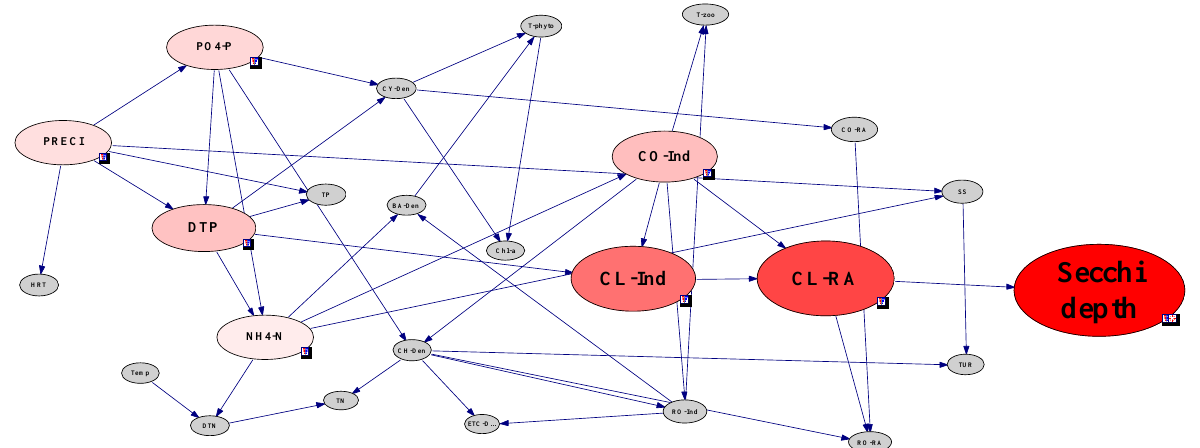
Figure 5. Sensitivity test and strength of influence analysis based on the Bayesian network approach for assessing the CWP in St. 1 near the Paldang dam. All data for St. 1 used in the Bayesian network were discretized by a hierarchical method and bin count 3.